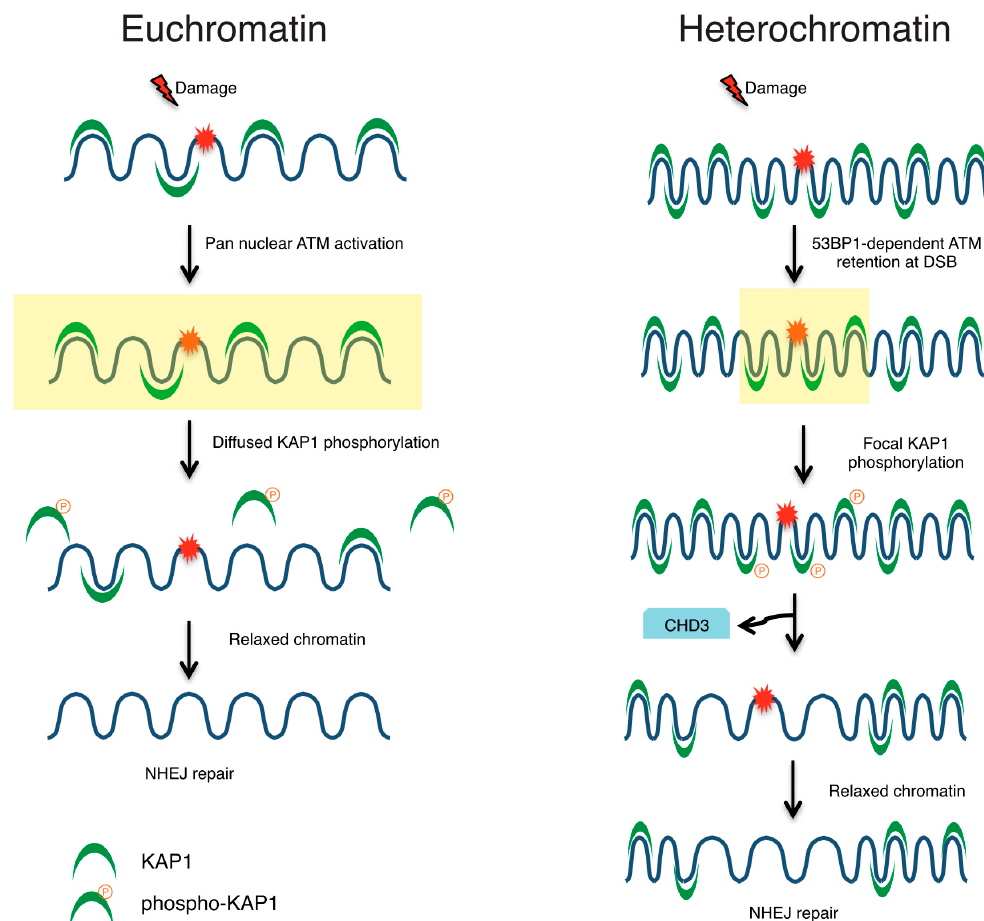
Figure 3. DNA damage response in euchromatin vs. heterochromatin. DNA DSBs within euchromatic regions of the genome result in global activation of the ATM kinase that in turn affects KAP1 phosphorylation in a diffused manner. KAP1 phosphorylation and release from chromatin promotes repair through enhanced access to damage site. However, when damage occurs within heterochromatic regions, ATM activity is retained at the site of DSB in a 53BP1-dependent manner. In this manner, 53BP1 functions to retain several factors onto the damage site and also facilitate localized KAP1 phosphorylation and dissociation of CHD3 in turn leading to chromatin